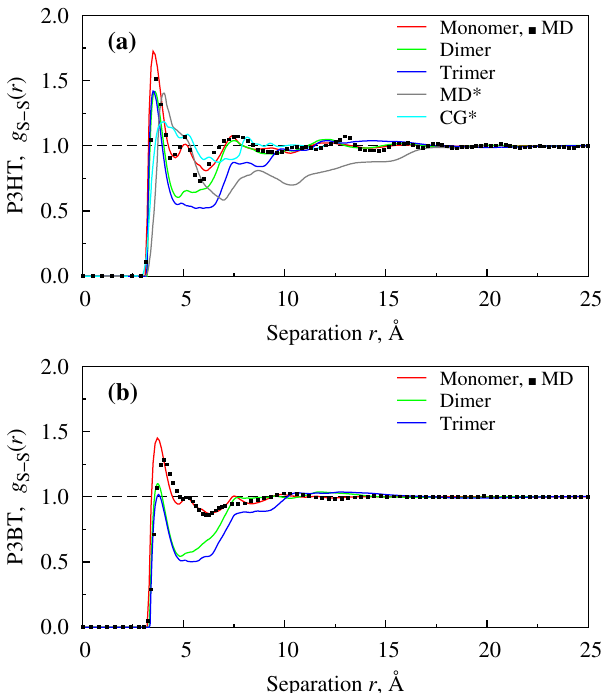
Figure 3. Radial Distribution Functions (RDFs) for S–S interaction sites belonging to neat films P3HT ( a ) and P3BT ( b ), modelled as monomers, dimers or trimers at 400 K. MD ∗ data are taken from [70] and CG ∗ from